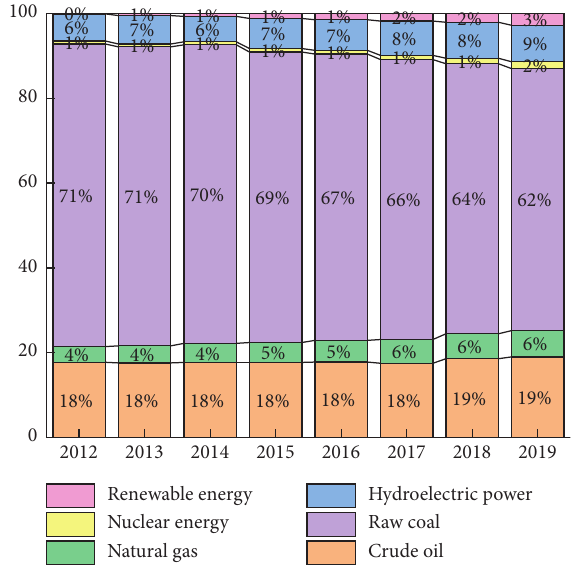
Figure 2: Energy consumption